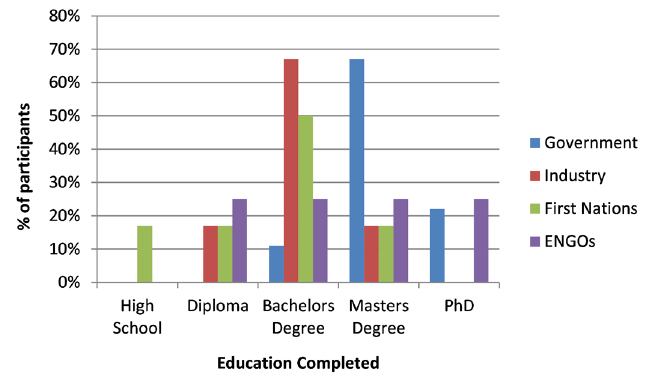
Figure 1. Distribution of completed education, represented as a proportion of categorized group.